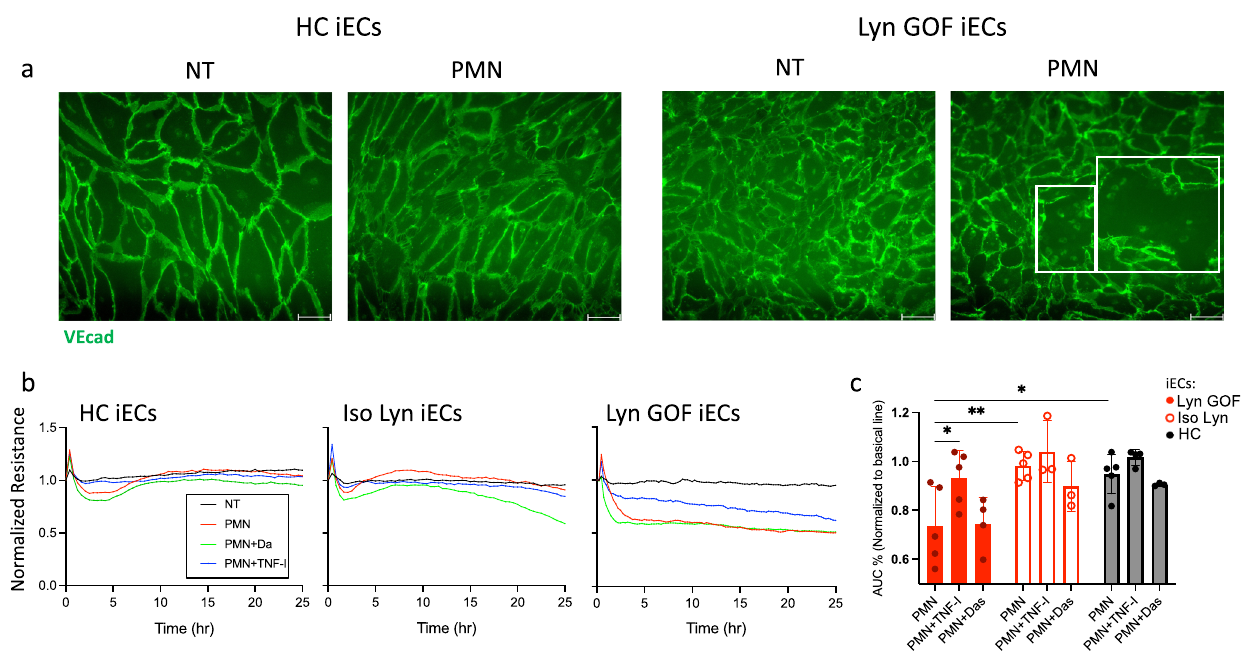
Fig. 6 | Co-culture of neutrophils decreases transendothelial electrical resis- tance by electric cell-substrate impedance sensing (ECIS) in mutant but not isogeniciECs.a Co-cultureofneutrophilswithiECsleadstodecreasedVE-cadherin staining(green)inPt.1iECs(LynGOFiEC,whiteboxes)comparedtohealthycontrol (HC) iECs. Scale bars, 50 μ m. b , c ECIS data presentation of baseline absolute resistance (ohm, Ω ) in iECs from Lyn GOF and isogenic control (iso Lyn) as well as HC iECs. Real-time ECIS measurement of transendothelial electrical resistance (TEER) across the endothelial monolayer upon co-culture with HC neutrophils (= polymorphonuclearcells,PMN)showsadecreaseinLynGOFiECscomparedtoHC ( p =0.0240) and iso Lyn iEC ( p =0.0099). Treatment with a TNF inhibitor (TNF-I, p =0.0126)improvedTEERinLynGOFiEC.Absolutevalueswerenormalizedtothe